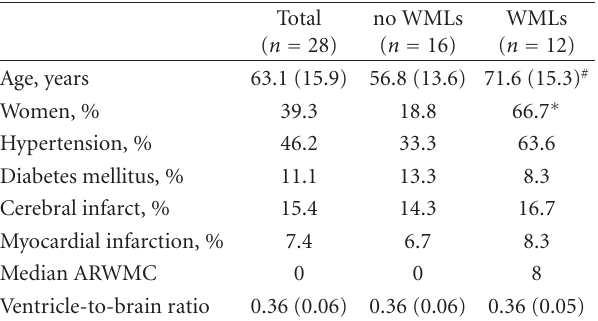
Table 1: Characteristics of the study